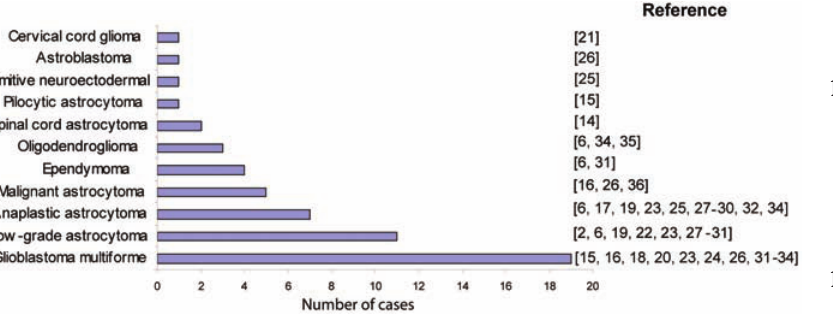
Figure 4. Glioblastoma multiforme is the most common type of reported glioma in HIV- 1 seropositive individuals. Graphical representation of the distribution of gliomas report- ed in AIDS patients by histological type. References are indicated within